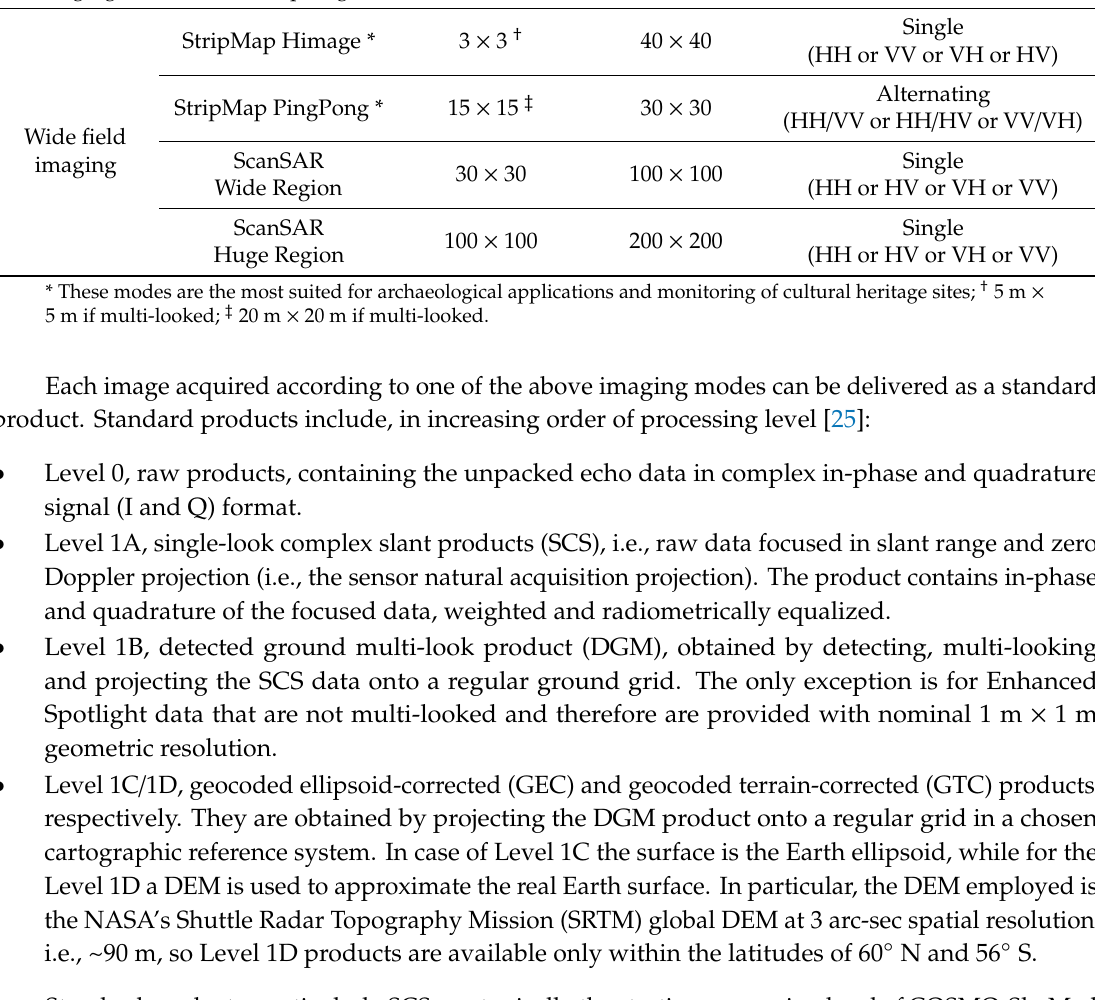
Table 1. Summary of COSMO-SkyMed imaging modes available for the civilian and defence use domain (excludingmodeSpotlight-1, whichisreservedfordefenceuseonly). Notation: rg—range;az—azimuth. Resolution rg Swath Polarization Imaging Mode × az [m × m] [km × km] Single Narrow field Spotlight-2 or 1 × 1 10 × 10 (HH or VV) imaging Enhanced Spotlight * Single StripMap Himage * 3 × 3 † 40 × 40 (HH or VV or VH or HV) StripMap PingPong * 15 × 15 ‡ Wide field ScanSAR imaging Wide Region